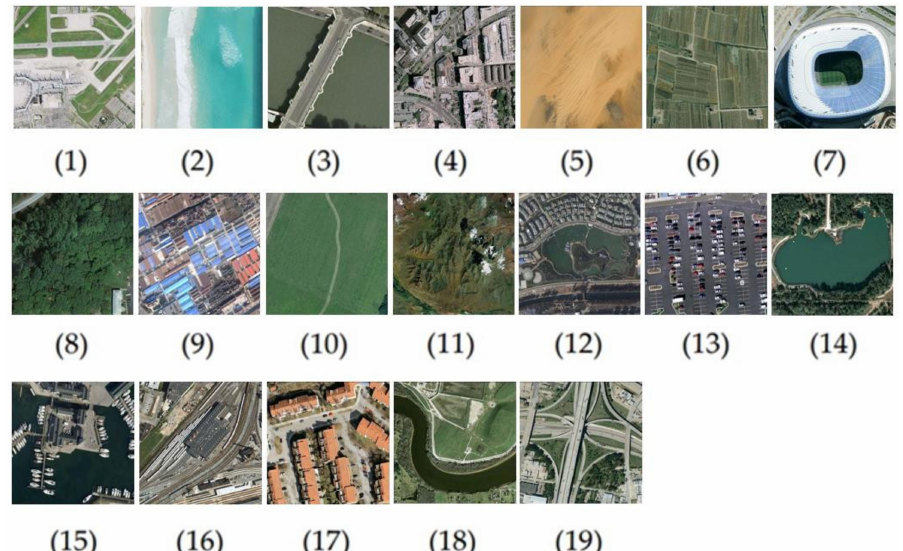
Figure 2. Sample images of WHU-RS19 dataset: ( 1 ) airport, ( 2 ) beach, ( 3 ) bridge, ( 4 ) commercial area, ( 5 ) desert, ( 6 ) farmland, ( 7 ) football field, ( 8 ) forest, ( 9 ) industrial area, ( 10 ) meadow, ( 11 ) mountain, ( 12 ) park, ( 13 ) parking lot, ( 14 ) pond, ( 15 ) port, ( 16 ) railway station, ( 17 ) residential area, ( 18 ) river, and ( 19 )